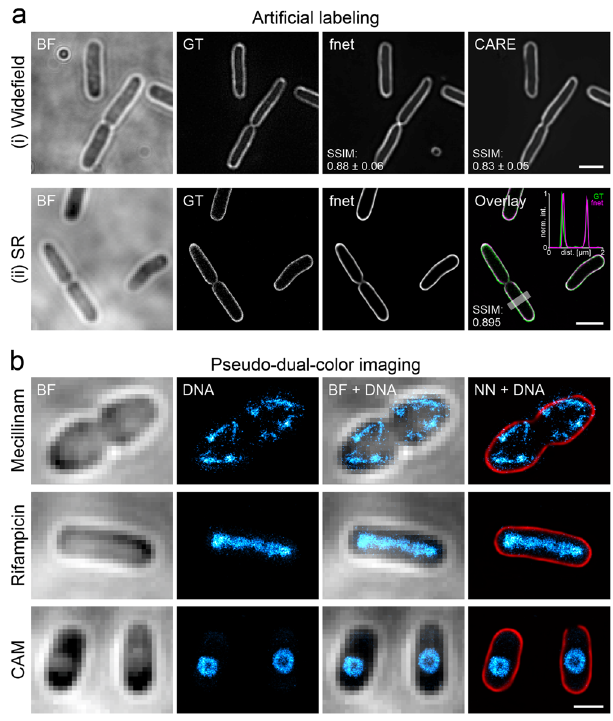
Fig. 5 Arti fi cial labelling of E. coli membranes. a fnet and CARE predictions of diffraction-limited (i) and PAINT super-resolution (SR) (ii) membrane labels obtained from bright fi eld (BF) images. GT = ground truth. Values represent averages from fi ve test images and the respective standard deviation b Pseudo-dual-colour images of drug-treated E. coli cells. Nucleoids were super-resolved using PAINT imaging with JF 646 -Hoechst 64 . Membranes were predicted using the trained fnet